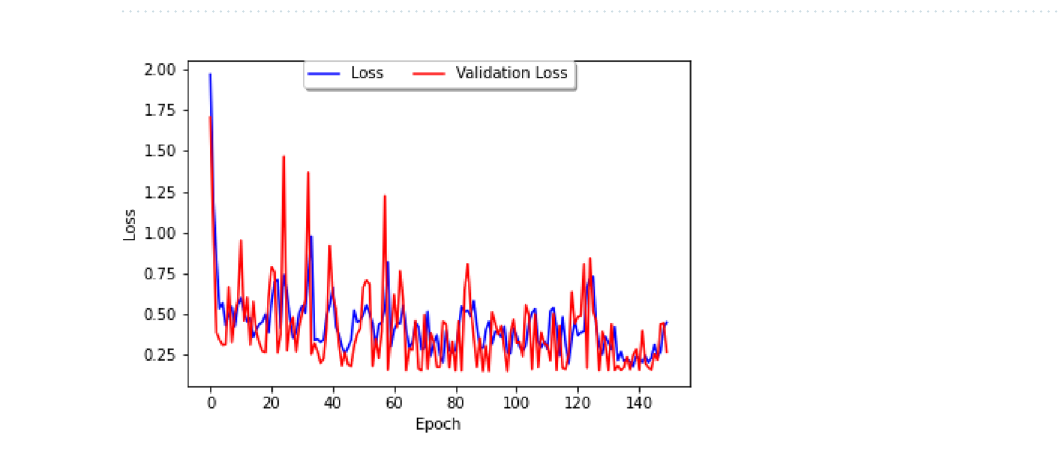
Figure 15. A graph of the actual data and the predicted data for Perú, for when both holiday and climate factors are considered on the training set (left) and the test set (right).